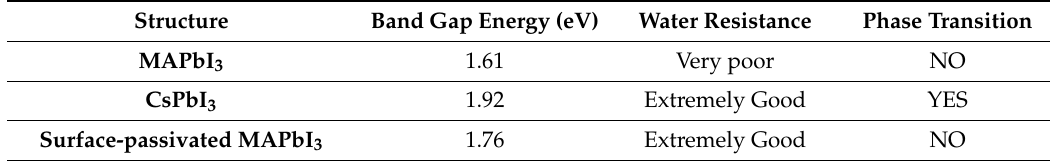
Table 2. Properties of perovskite materials for solar cell [20].